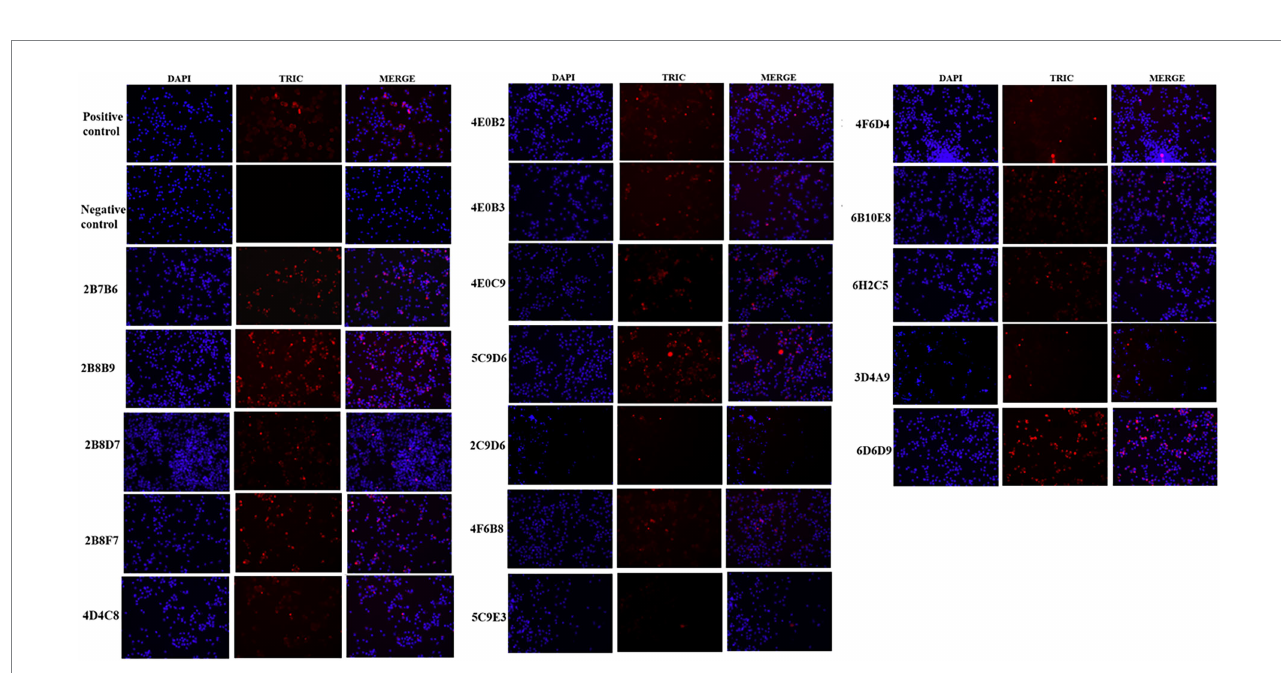
FIGURE 3 Reactivity of 17 mAbs in the indirect immunofluorescence assay (IFA). The positive control was ASF-positive serum and uninfected PAMs were used as the negative